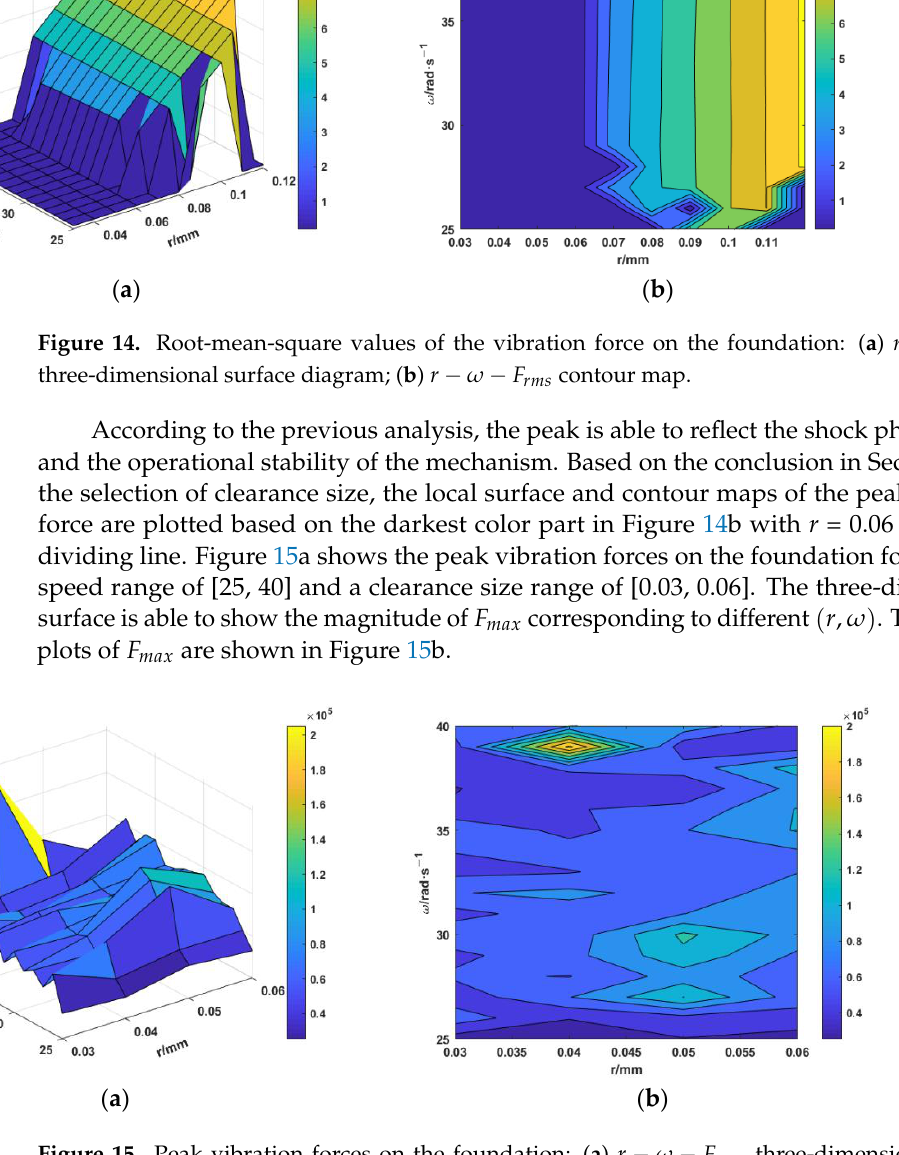
( d ) Figure 13. Poincare mapping at different clearance sizes. ( a ) 𝑟 = 0.03 . ( b ) 𝑟 = 0.06 . ( c ) 𝑟 = 0.09 . ( d ) 𝑟 = 0.12 . 5.3. Influence of Driving Speed and Clearance Size